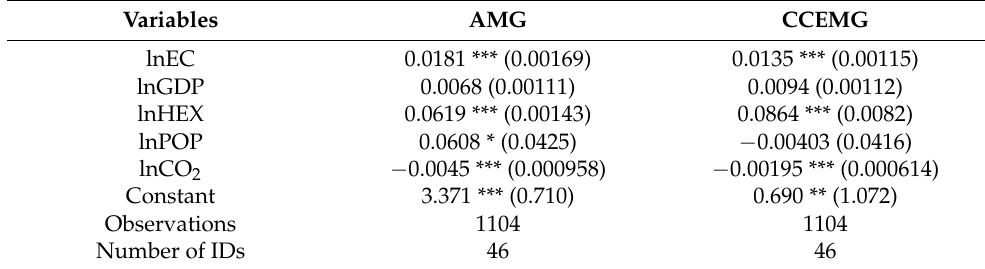
Table 8. Robustness of long-run